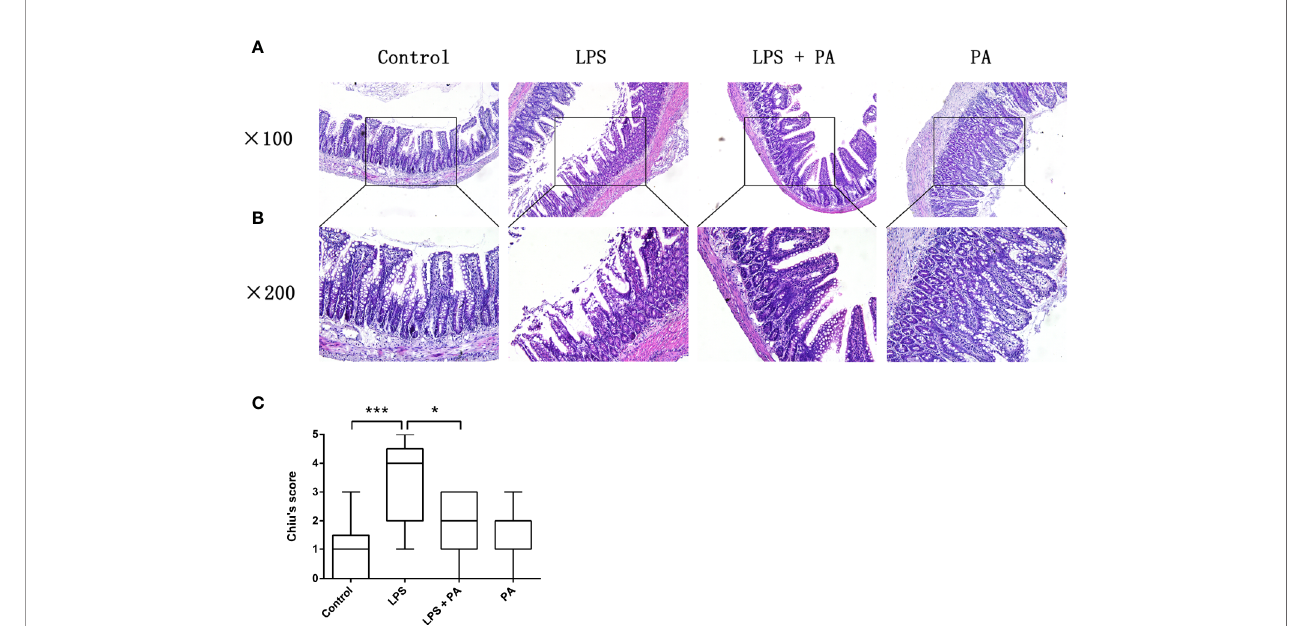
FIGURE 7 | The effects of PA on intestinal histology. Histological sections of the ileum harvested 24 h after LPS treatment in rats with and without PA treatment. The ileal specimens were stained with hematoxylin and eosin and observed under a microscope of (A) 100 and (B) 200 magni fi cations. (C) Chiu ’ s score of intestinal specimens in each group. The data represent the averages ± S.D. Signi fi cant differences between the treatment and control groups are indicated as *P < 0.05, ***P < 0.001. Signi fi cance was determined by one-way